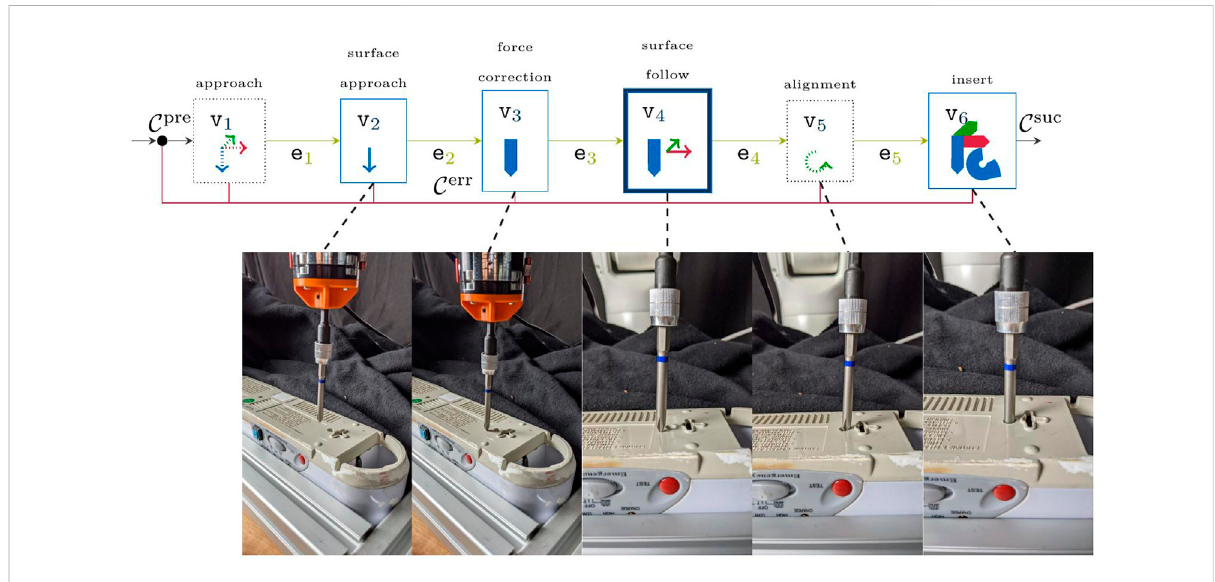
FIGURE 4 Schematic screw-insertion skill as an MP-graph. Each vertex shows the dedicated control direction, and thus the selection matrix from (14), where bold arrows represent force control and thin lines velocity control. Straight arrows in each MP denote translation with respect to axes ct e x , ct e y and ct e z .Circulararrowsdenotearotationalongthededicatedaxis.Parametricnodesarehighlightedbyasolidedge,whereasabold edge denotes a hybrid control